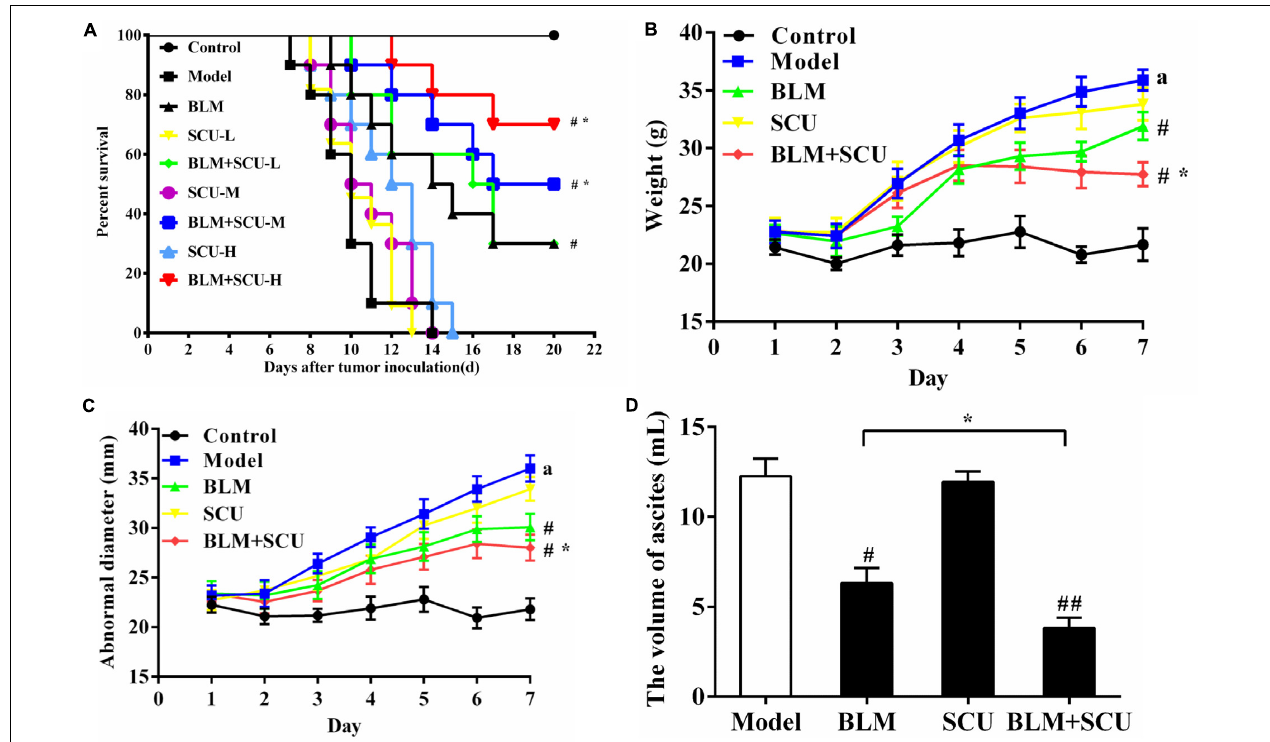
FIGURE 1 | Effects of SCU, BLM, and their combination on tumor-bearing mice. (A) The survival curves of mice. The survival rate was followed up to 22 days after inoculation. (B) The weight of mouse. (C) The abnormal diameter of mouse. (D) The ascites volume of mouse. Each point represents the mean ± SD. ( n = 8). # p < 0.05 compared with model group; ## p < 0.01 compared with model group; ∗ p < 0.05 compared with BLM group; a < 0.05 compared with control